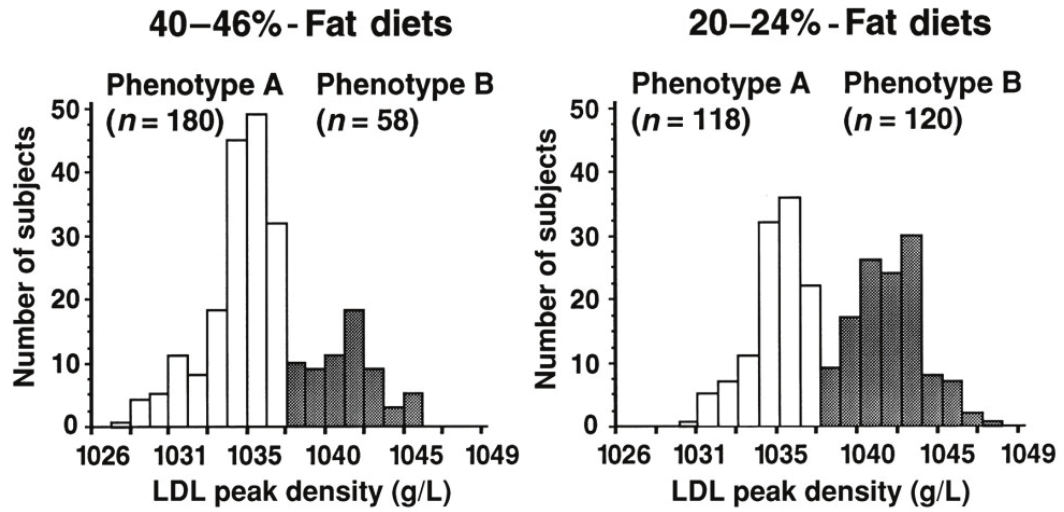
Figure 2. Distribution of LDL peak particle densities determined by analytic ultracentrifugation in 238 men consuming high-fat (40–46% of energy from fat) and low-fat (20–24% of energy from fat) diets. White bars represent subjects with LDL subclass phenotype A and shaded bars subjects with LDL subclass phenotype B. Reprinted with permission